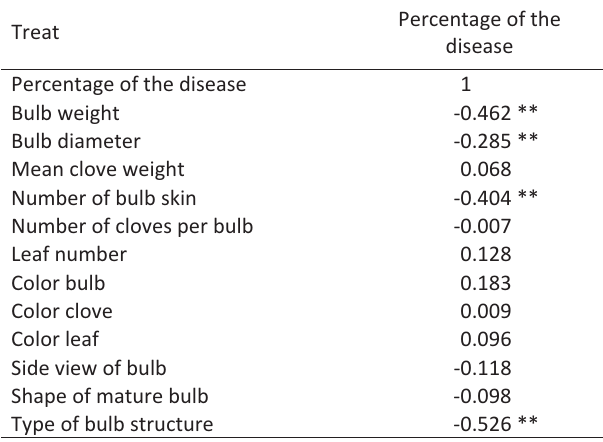
12 ­ Correlation coefficients between Morphological traits and resistance to rust ( Puccinia allii ) in Iranian garlic clones measured by Pearson's two­domain test